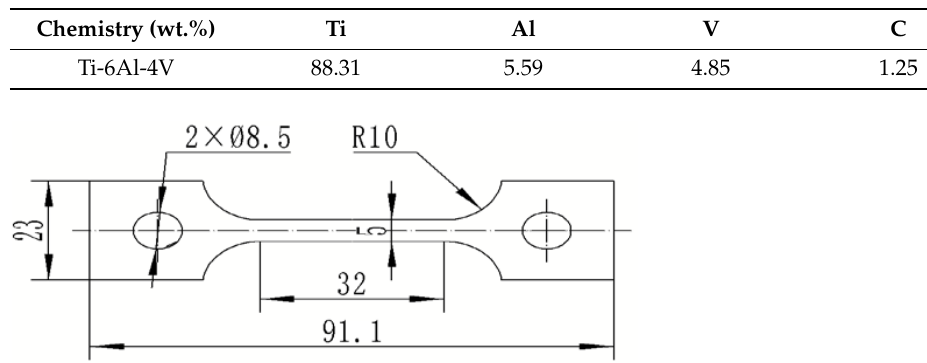
Figure 2. Dimensions of the high-temperature tensile test specimen (mm).